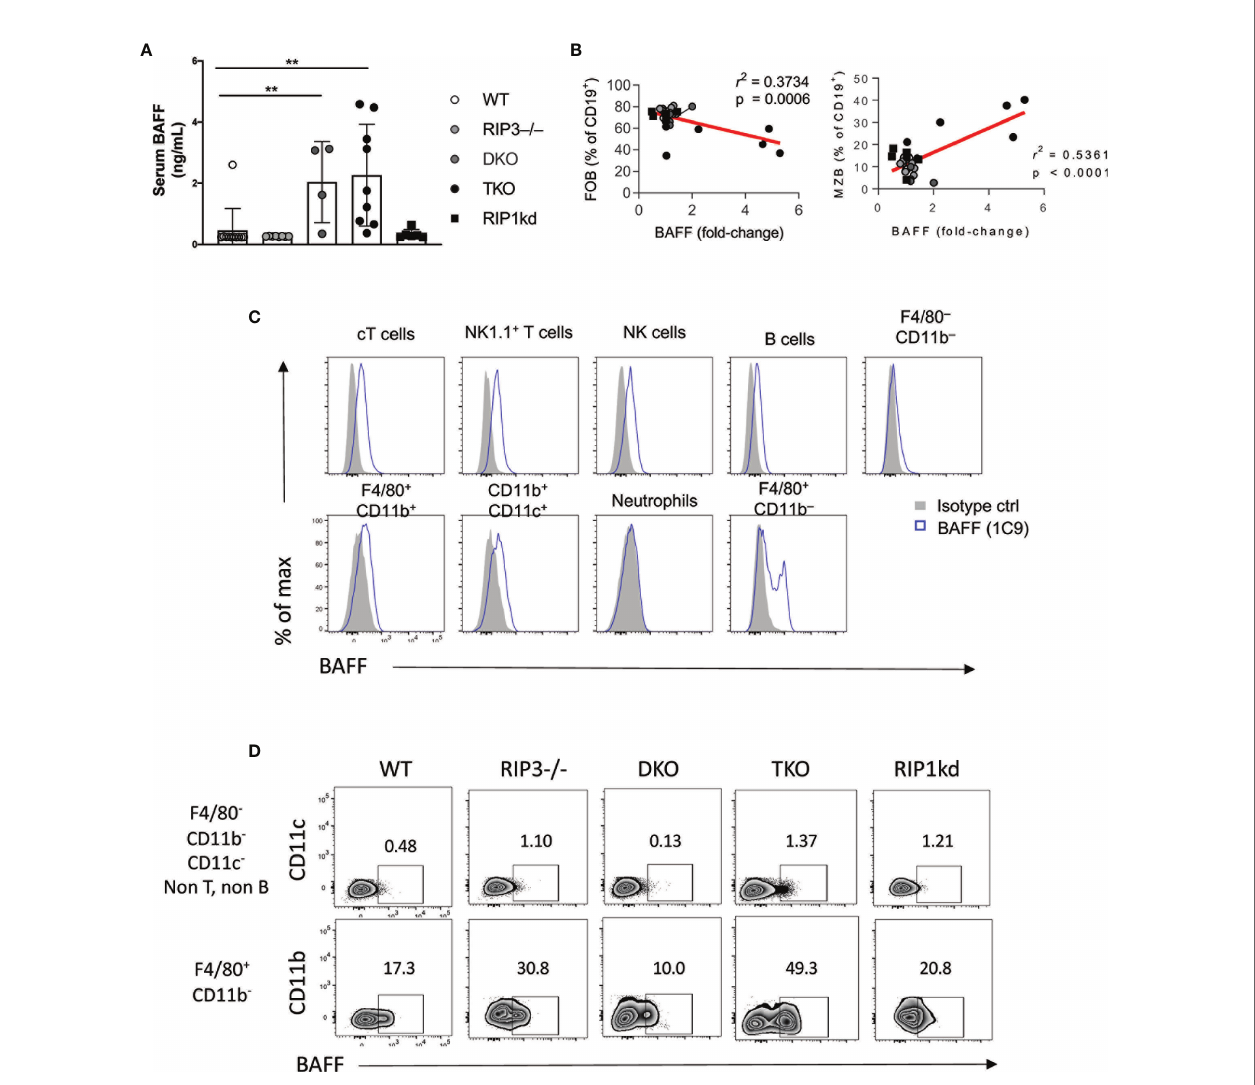
FIGURE 3 | RIP1 and caspase-8 restrain BAFF production by myeloid cells. ELISA detects BAFF in serum from C57BL/6 WT, RIP3-/-, DKO, TKO and RIP1 kd mice (A) . Serum BAFF levels correlate with FO B cell (left) and MZ B cell (right) frequencies (B) . Flow cytometry reveals intracellular BAFF in indicated lymphocyte subsets labeled with anti-BAFF (1C9) or isotype control (C) . Flow cytometry further identi fi ed intracellular BAFF in F4/80 + and F4/80 - cells from C57BL/6 WT, RIP3-/-, DKO, TKO and RIP1 kd mice (D) . Data is representative (C, D) or a pool (A, B) of two independent experiments with 2-4 mice per group, aged 8-28 weeks. Each symbol indicates an individual mouse. **p ≤ 0.01 (One-way ANOVA, Unpaired two-tailed test and simple linear